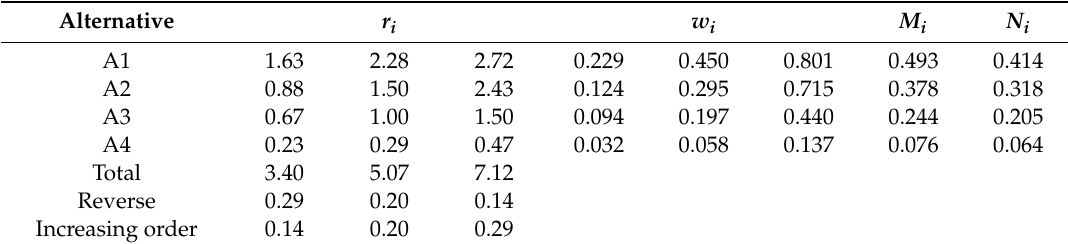
Table 10. Results of r i , W i , M i and N i in respect to the e ff ectiveness criteria.